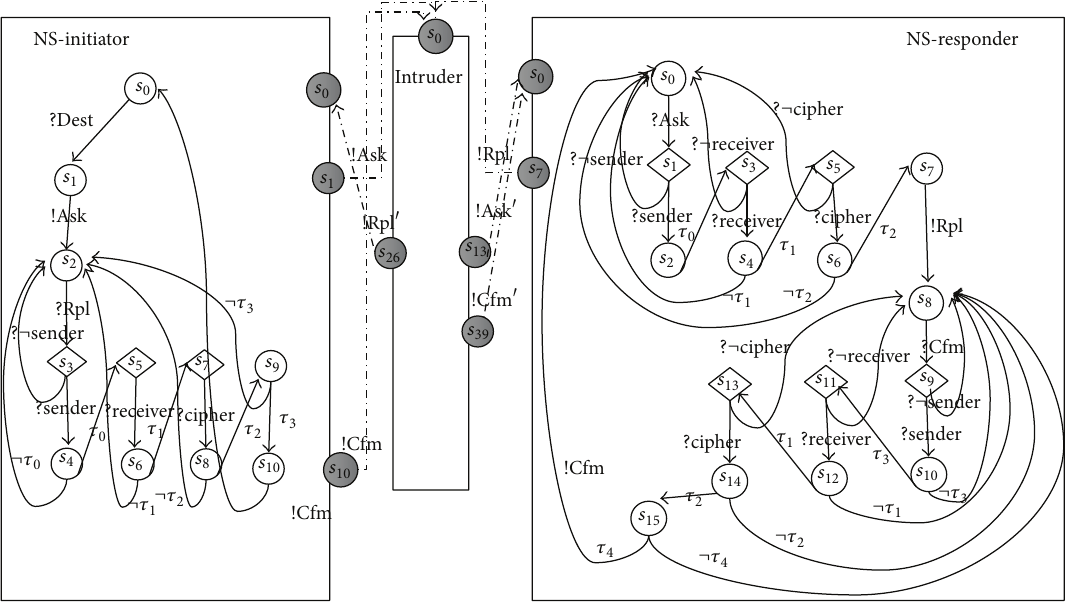
Figure 4: Intruder contained model,